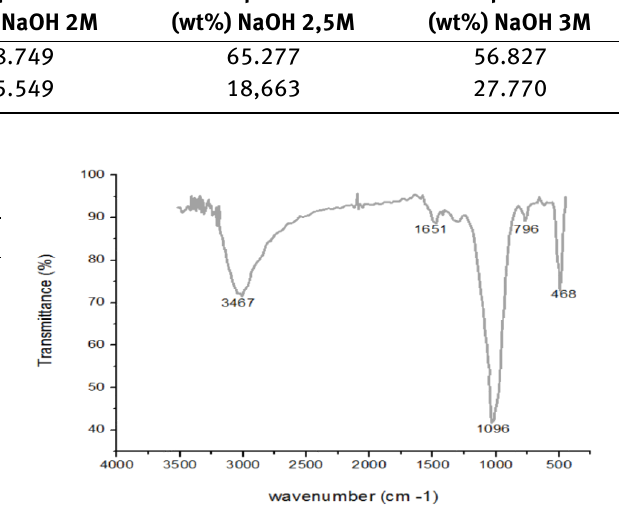
Figure 4: FTIR characterization graph Table 5: Functional group and Wave